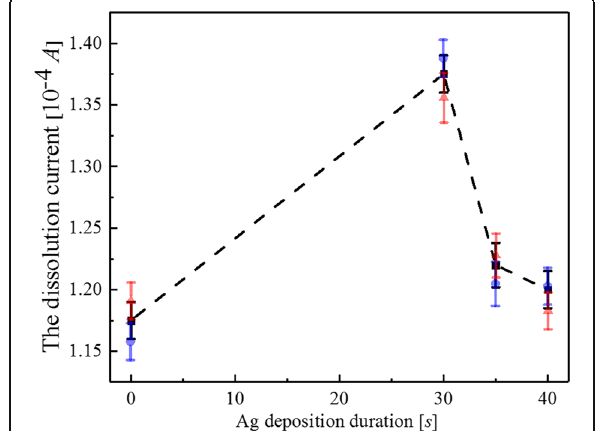
Fig. 8 The relationship between the time of Ag ion deposition on TiO 2 nanotube array and the detection concentration of Fe 3+